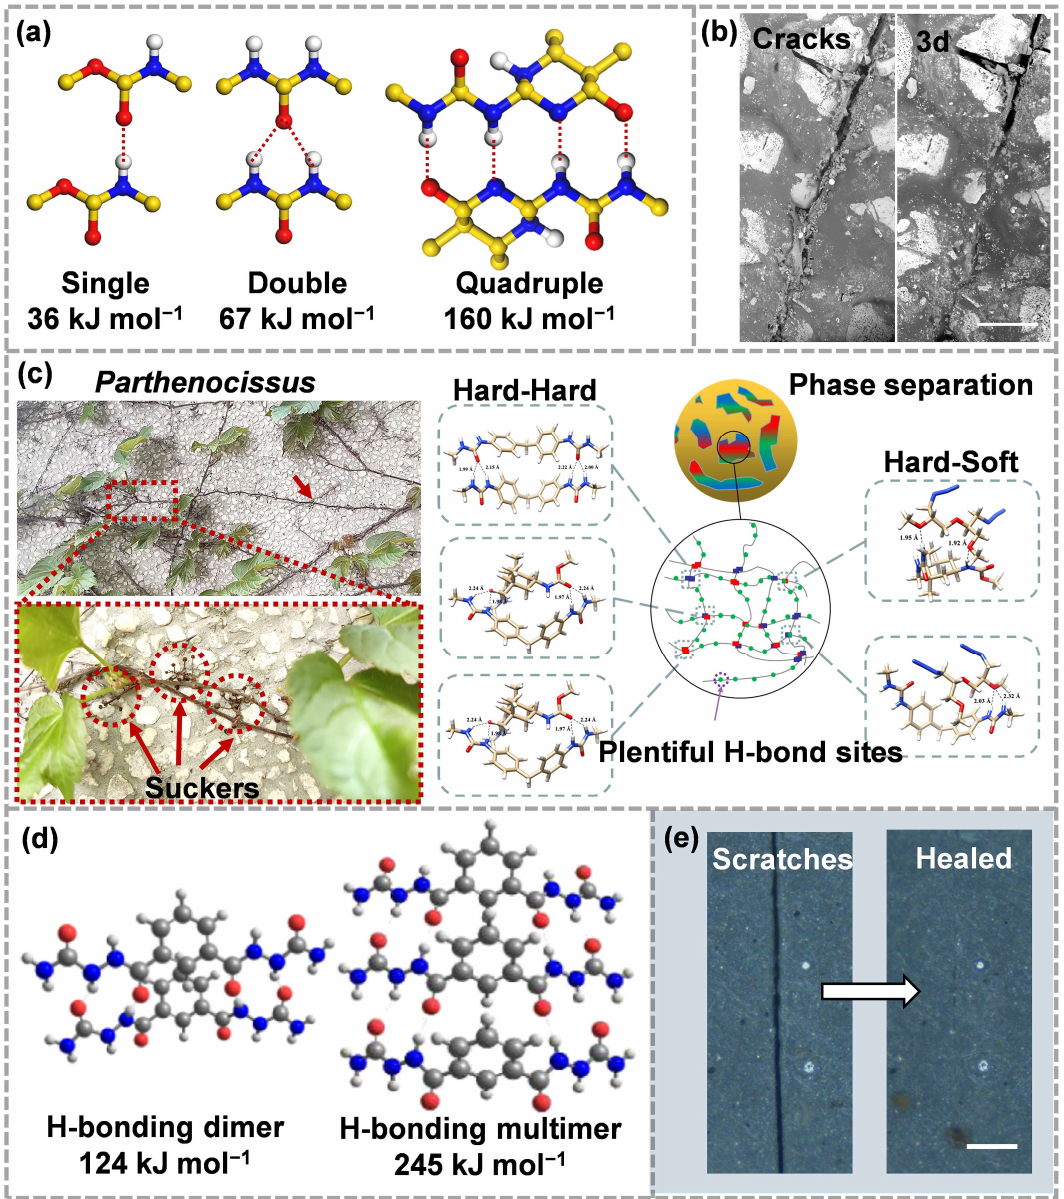
Figure 7. ( a ) Bonding energies of single, double(reproduced from Ref. [96] with permission; Copyright Royal Society of Chemistry, 2022) and quadruple hydrogen bonds (reproduced from Ref. [95] with permission; Copyright American Chemical Society, 2011), ( b ) scratches on the propellant containing hydrogen bonds as binders before and after self-healing(reproduced from Ref. [100] with permission; Copyright Royal Society of Chemistry, 2021), ( c ) schematic illustration of Parthenocissus with abundant suckers and chemical structures of a Parthenocissus-like self-healing energetic binder (reproduced from Ref. [81] with permission; Copyright Royal Society of Chemistry, 2021), ( d ) different H-bonded aggregates of ASCZ moieties and their corresponding stabilization energy (reproduced from Ref. [24] with permission; Copyright American Chemical Society, 2020), ( e ) optical microscope images of ECMs containing ASCZ moieties energetic adhesive demonstrating self-healing (reproduced from Ref. [107] with permission; Copyright Elsevier,